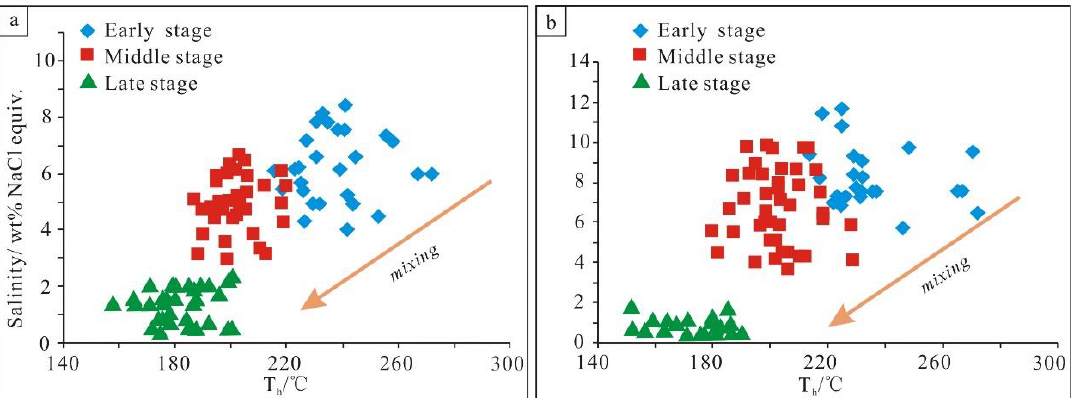
Figure 12. Th versus salinity of the fluid inclusions in different stages of the Changkeng–Fuwan Au ( a )-Ag ( b )